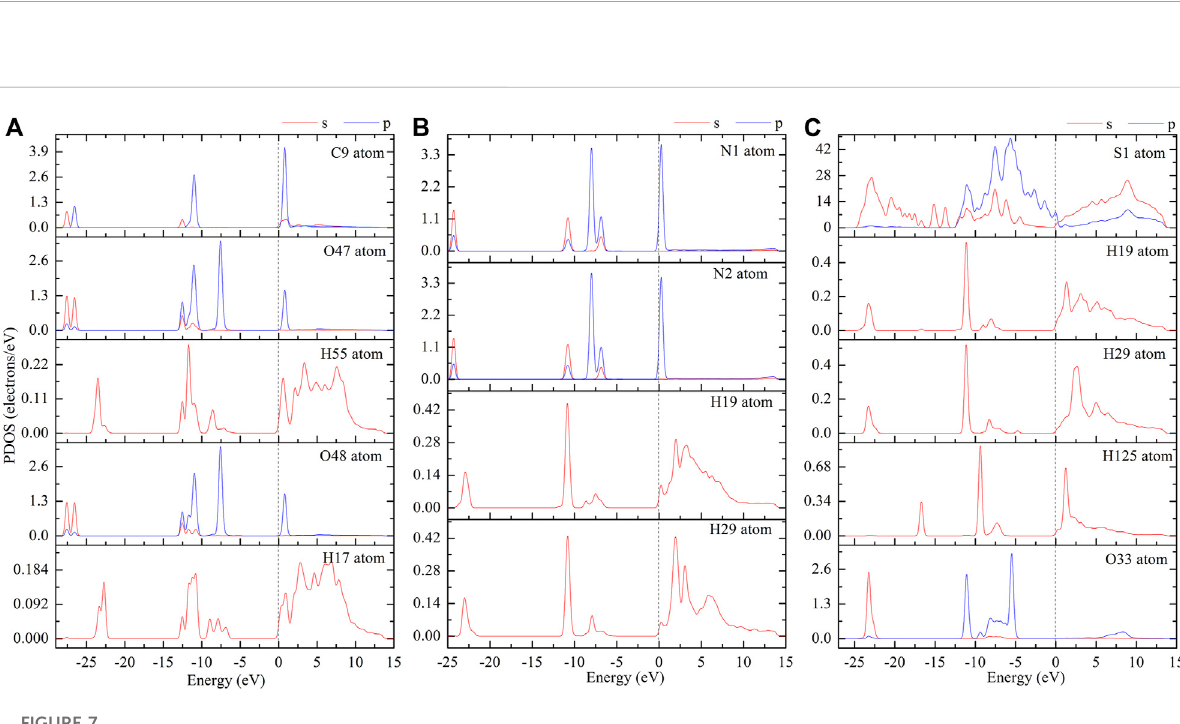
FIGURE 7 PDOS curves of absorbed CO 2 (A) , N 2 (B) , and H 2 S (C) on MH(001) surface (please refer to the atom names in Figure